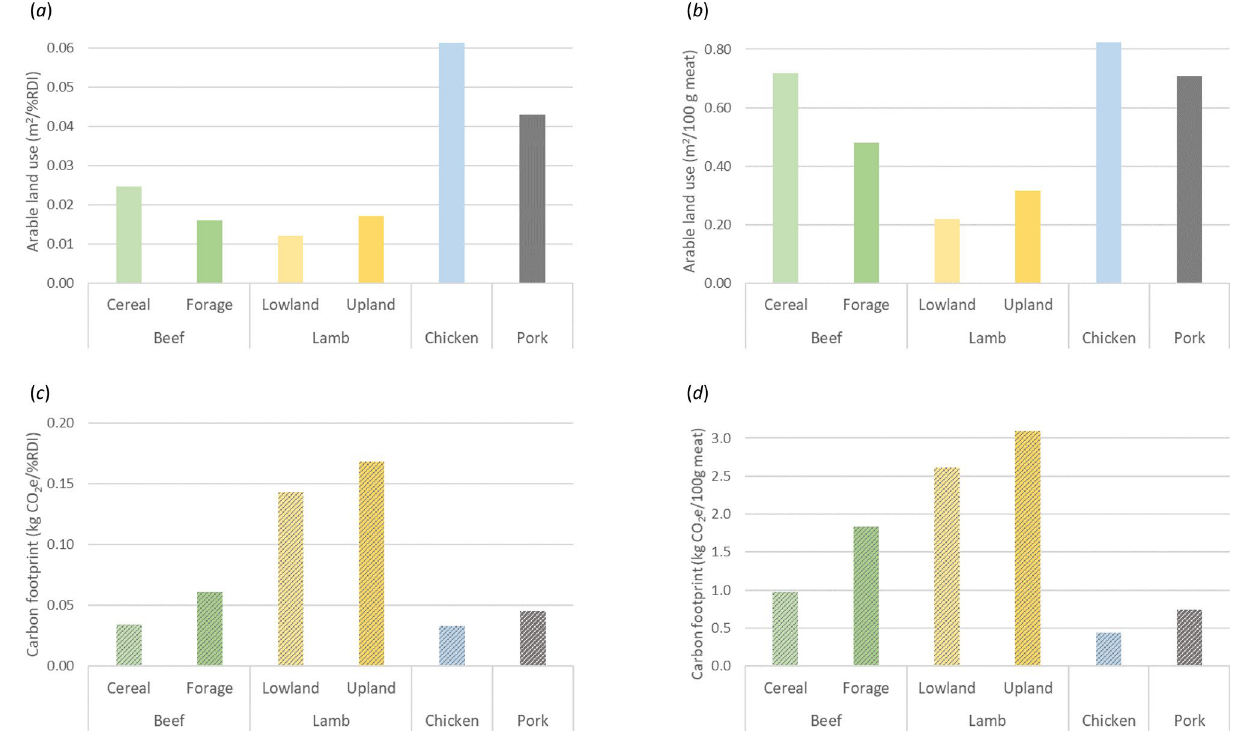
Figure 1. Arable land use per nutrient density score ( a ) and per mass of product ( b ), and carbon footprint per nutrient density score ( c ) and per mass of product ( d ) for six meat production systems commonly observed in the UK. The striking contrast in relative inter-system relationship between the figures demonstrates the challenge facing the sustainability debate surrounding livestock farming. Panels ( c ) and ( d ) were produced from data reported in an earlier study 25 under the Creative Commons licence CC BY